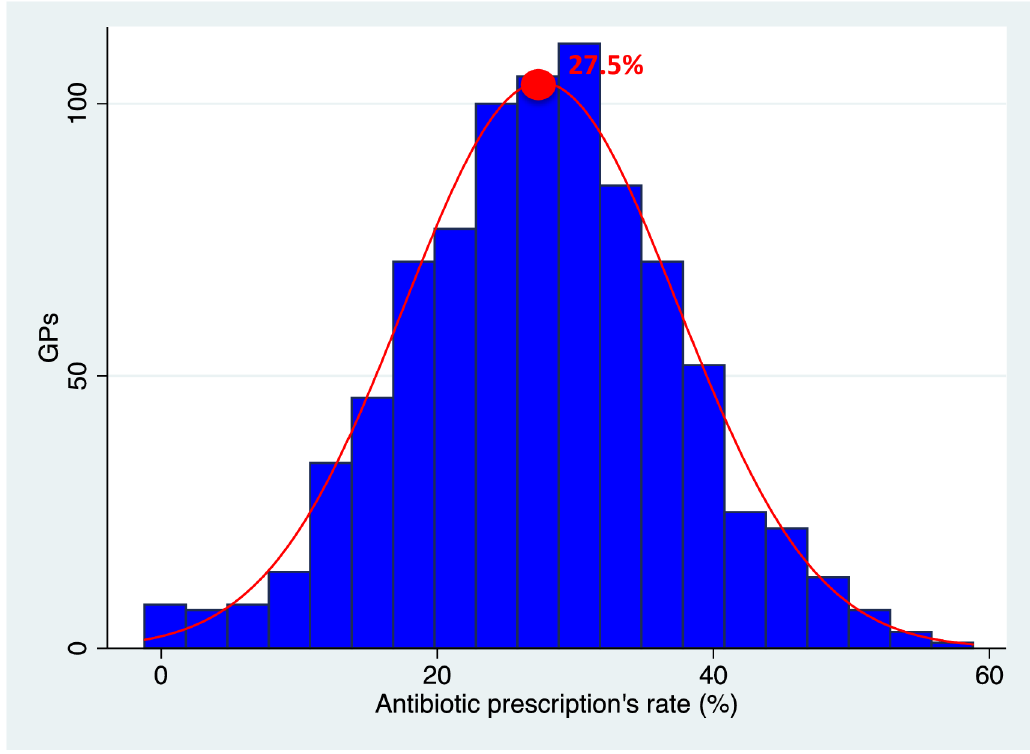
Fig 2. Distribution of antibiotic prescription. Lecture: The red point represents the mean antibiotic prescribing rate (27.5%).